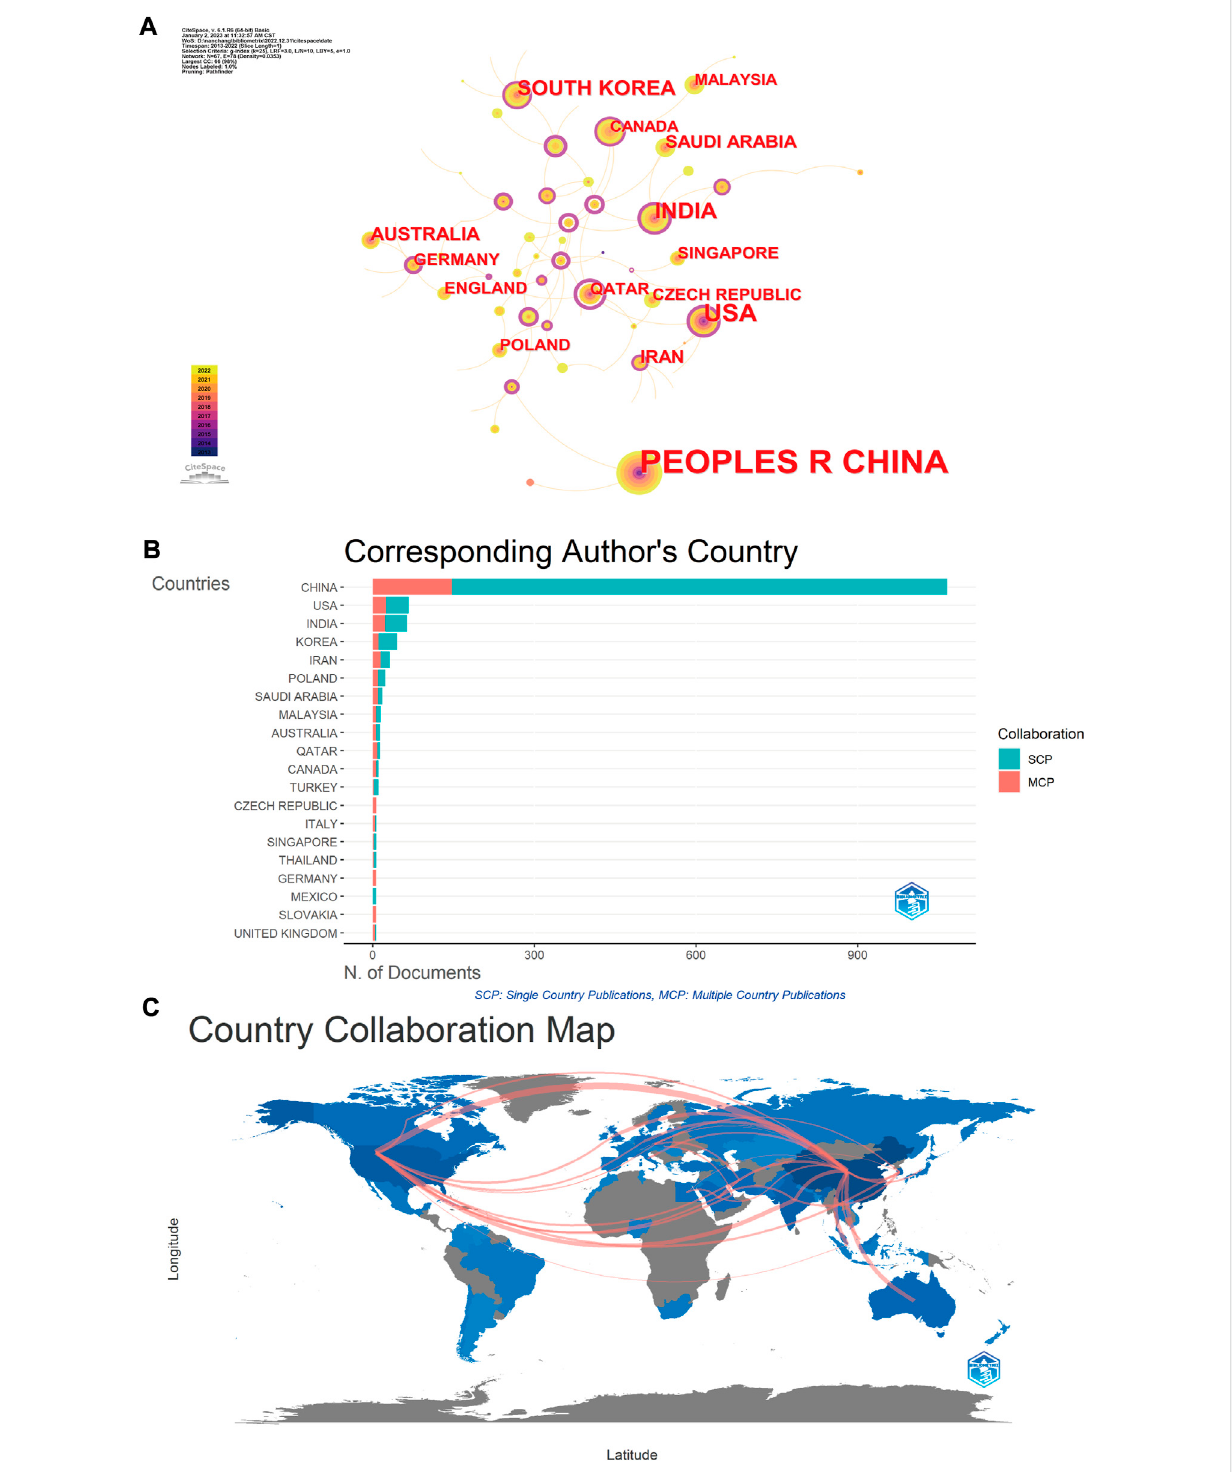
FIGURE 2 Visualization of the network map of countries. (A) Country distribution of MXene medical application. (B) Cooperation in the country where the corresponding author is located. (C) Map of cooperation between countries. SCP, single country publications; MCP, multiple country publications.